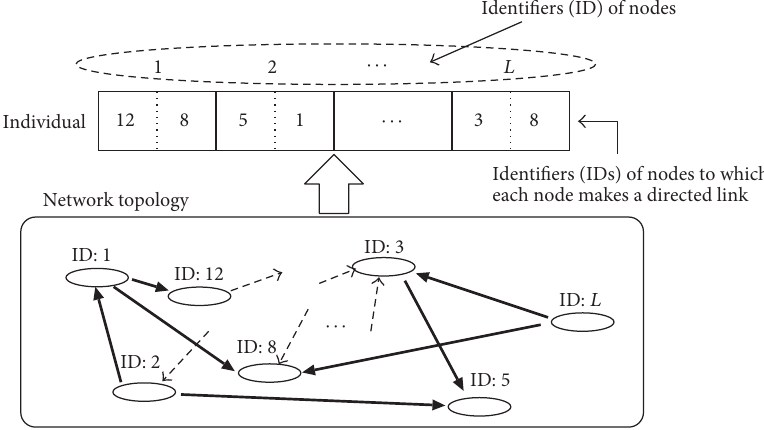
Figure 3: Representation of a P2P network topology in the EA (EA individual) when 𝑁 𝐶 = 2 .